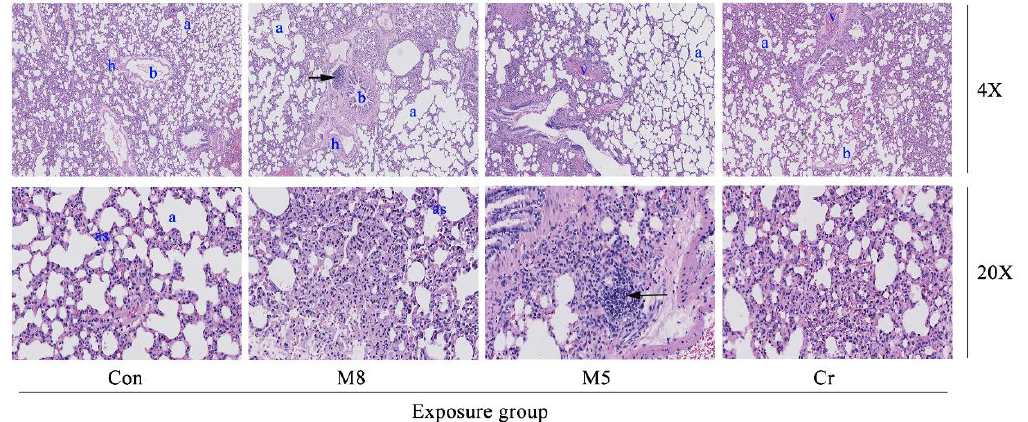
Figure 3. Photomicrographs of lung histopathology. The images (magnification 10 × , 20 × ) represent the histopathological sections of the lung. Dark arrows in the M8 group (10 × ) represent edema and exudation around bronchi, and a large number of inflammatory cells infiltrations. Dark arrows in the M5 group (20 × ) represent a large number of lymphocytic infiltration around bronchi. Abbreviations: Con, control group; M8: the mixture of eight common metals (Pb + Cd + Hg + Cu + Zn + Mn + Cr + Ni); M5: the mixture of five non-essential metals (Pb+Hg+Cd+Ni+Cr); Cr, chromium; a, alveolar space; b, bronchioles; h, histiocytes; as, alveolar septae; v, veins.